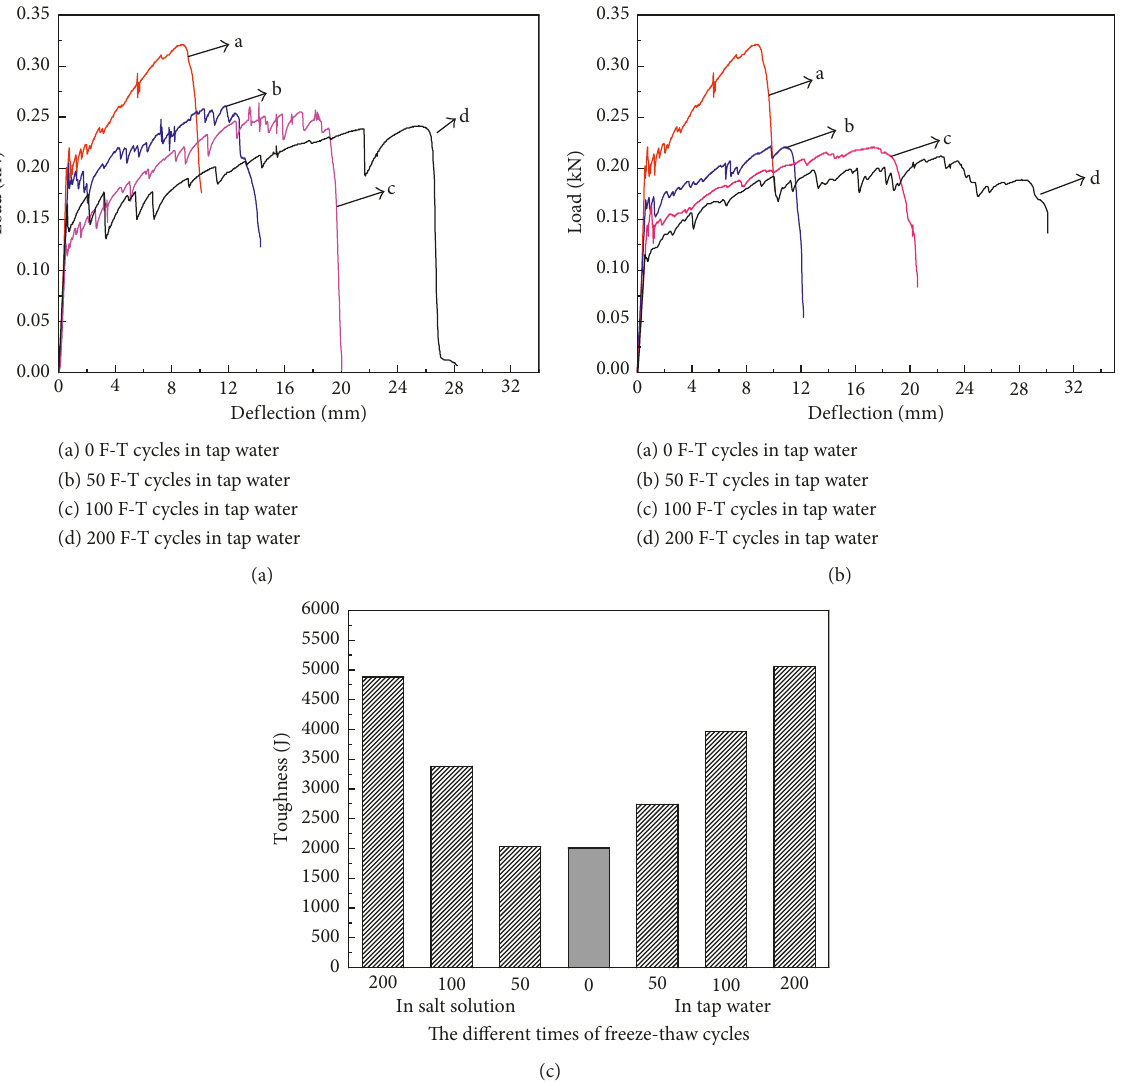
Figure 9: The load-deflection of ECC (65% FA +5% SF) subjected to different times of freeze-thaw cycle: (a) in tap water, (b) in sodium chloride (NaCl) solution, and (c) the corresponding toughness with different times of freeze-thaw